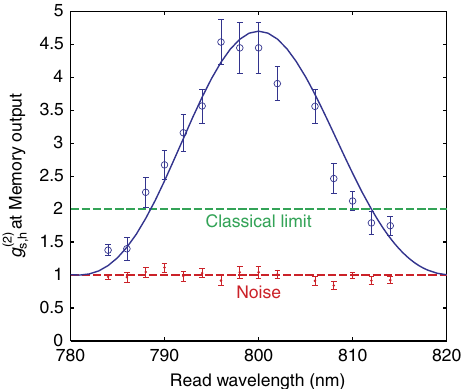
of frequency- Figure 3 | Range of frequency conversion. Measured g ð 2 Þ s ; h shifted photons. Frequency conversion, tuning the read beam over a 30nm range, is observed. Non-classical statistics, that is, g ð 2 Þ 4 2, are maintained s ; h over a 18nm range. The estimated g ð 2 Þ (solid line) which depends on s ; h sinc 2 ( D kL /2) agrees well with experimental data suggesting that the range of frequency conversion is determined by phase-matching conditions. Error bars show 1 standard deviation calculated assuming Poissonian